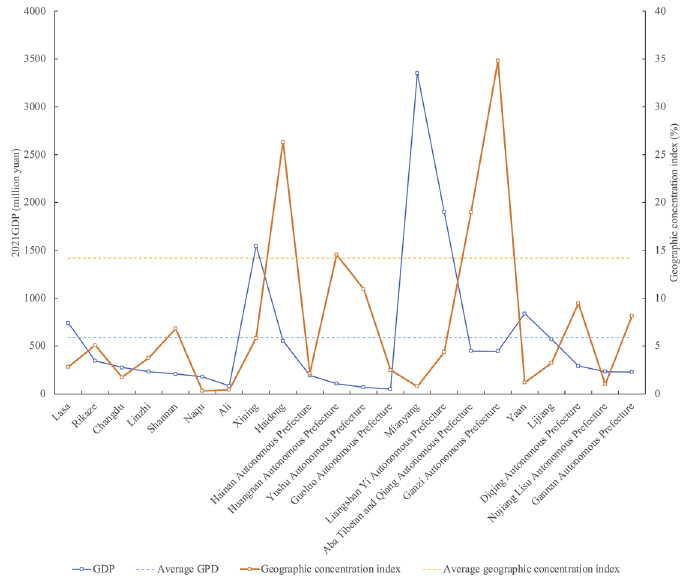
Figure 14. Economic development level and traditional village distribution on the Tibetan Plateau.